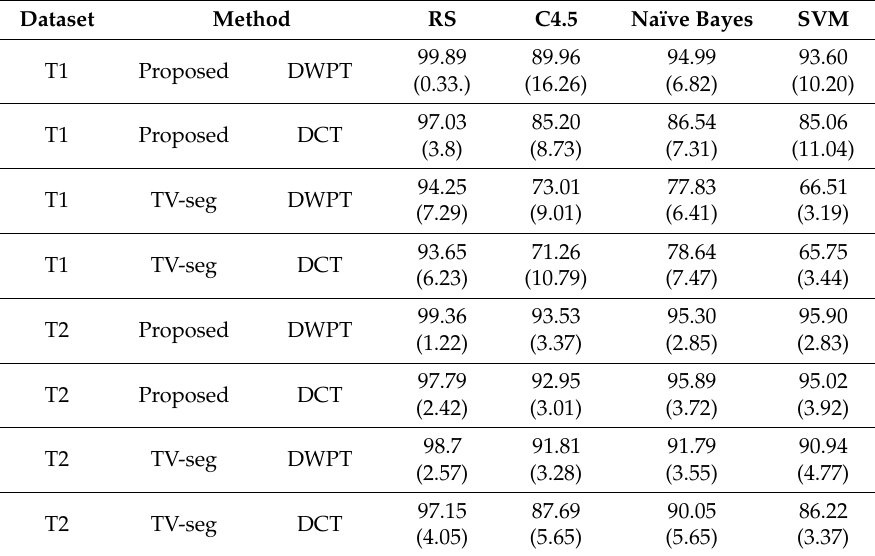
Table 3. The comparison results for different segmentation and decomposition